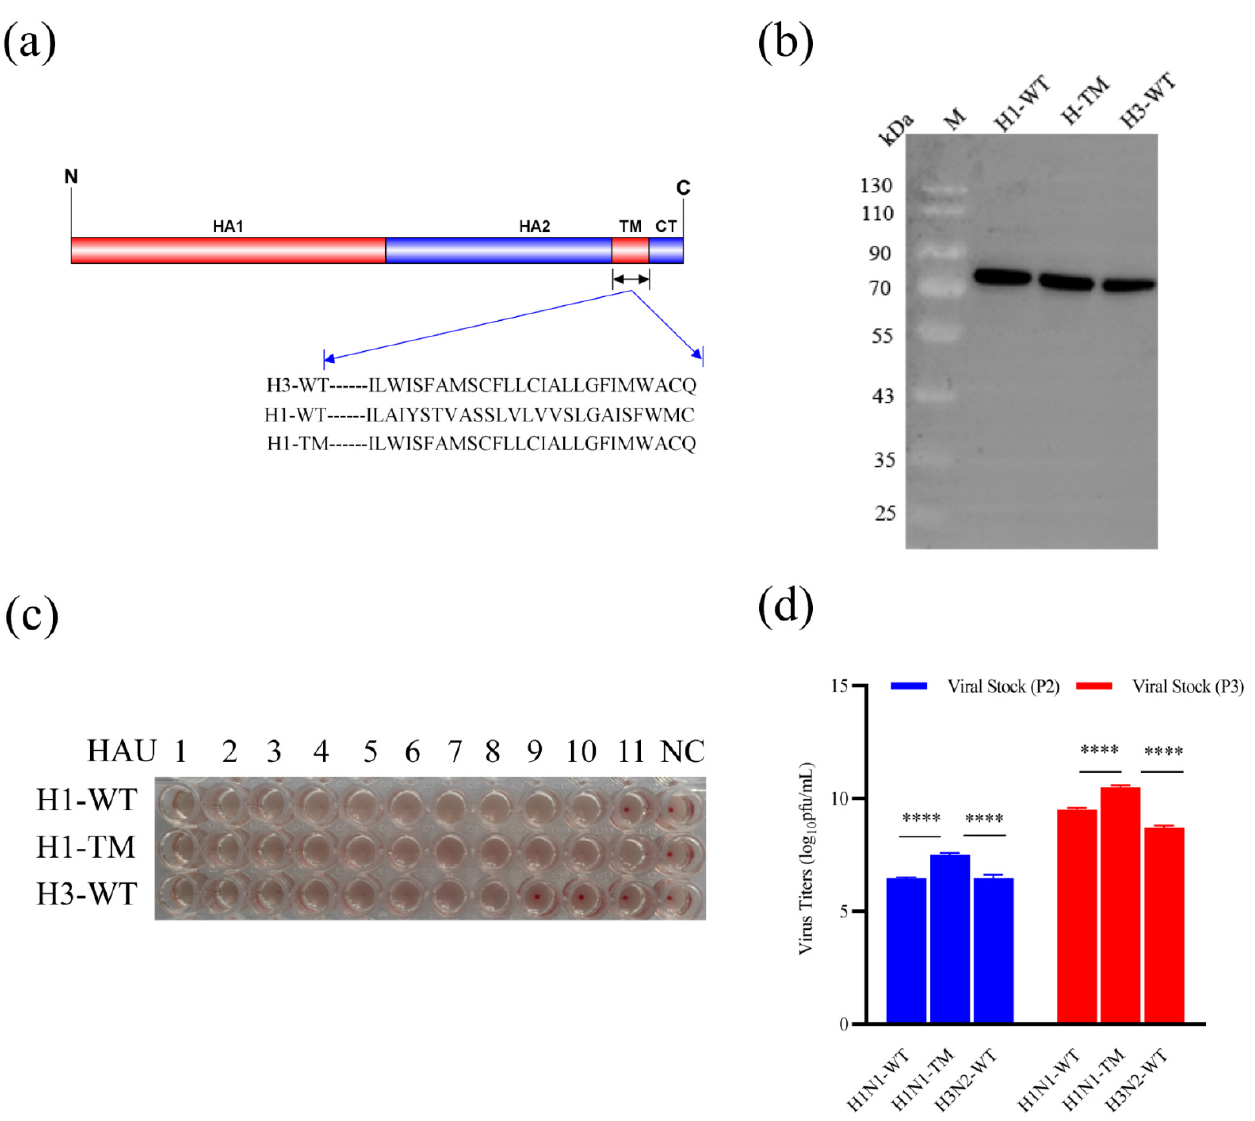
Figure 1. Recombinant baculovirus production and characteristic analysis. ( a ) Structural schematics of SIV HA proteins, where the amino acid sequences of the TM domain are shown. H3-WT denotes